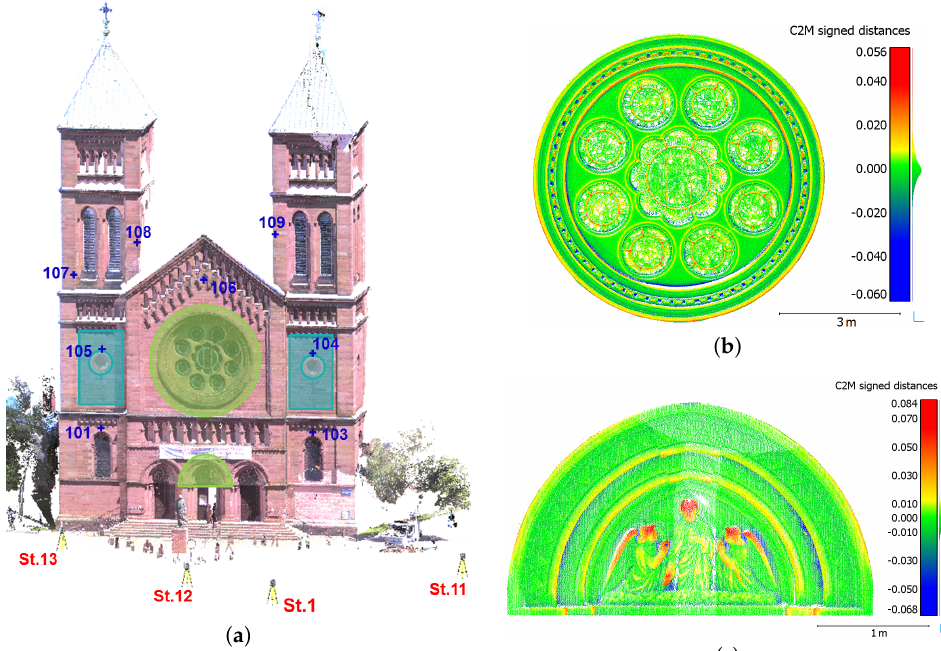
Figure 5. ( a ) Overview of the facade containing control points and locations of the areas selected for finer analyses; ( b , c ) Cloud-to-mesh comparisons performed on detailed areas between the SX10 point cloud and meshed parts of FARO Focus 3D point cloud: the rose window ( b ) and the tympanum ( c ). Deviations are in meters and projected on SX10 point